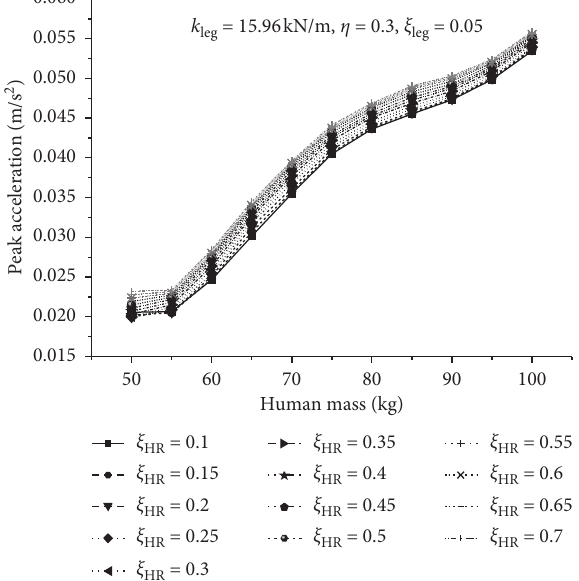
Figure 20: Peak acceleration under leg stiffness 15.96kN/m, η � 0 . 3, and ξ